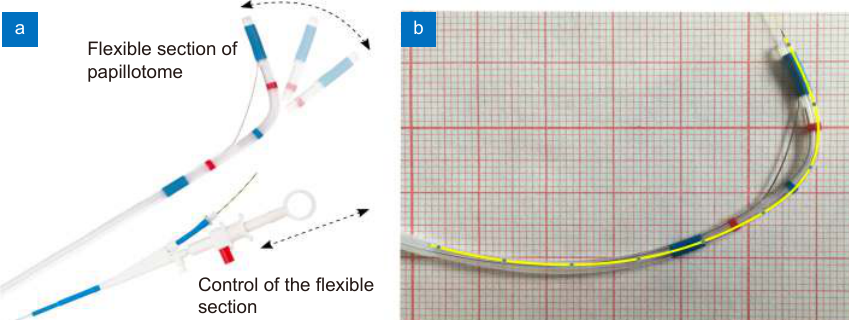
Fig. 9 | ( a ) Controlling the bending of the papillotome , and ( b ) result of the papillotome shape reconstruction with an integrated FBG array writ- ten in a 7-core fiber